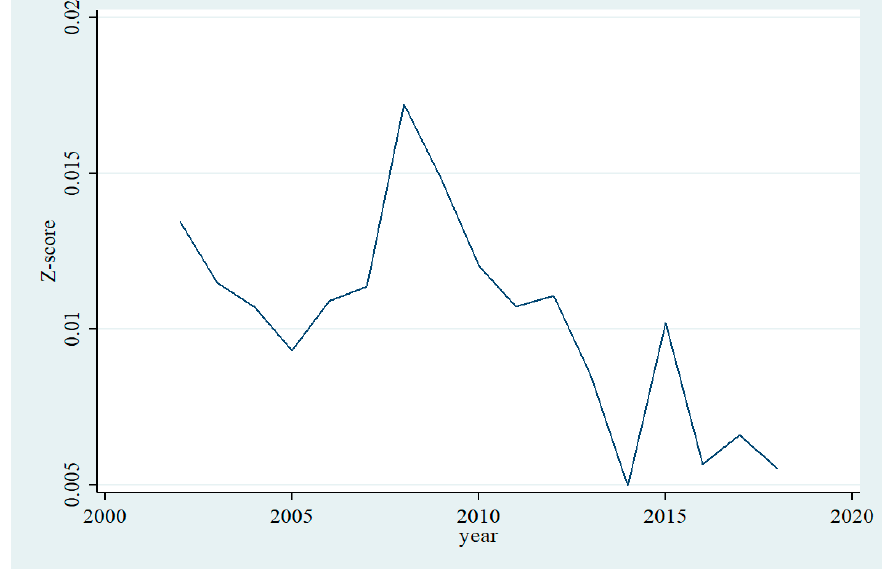
Figure 1. Z-score measure of exchange rate volatility.